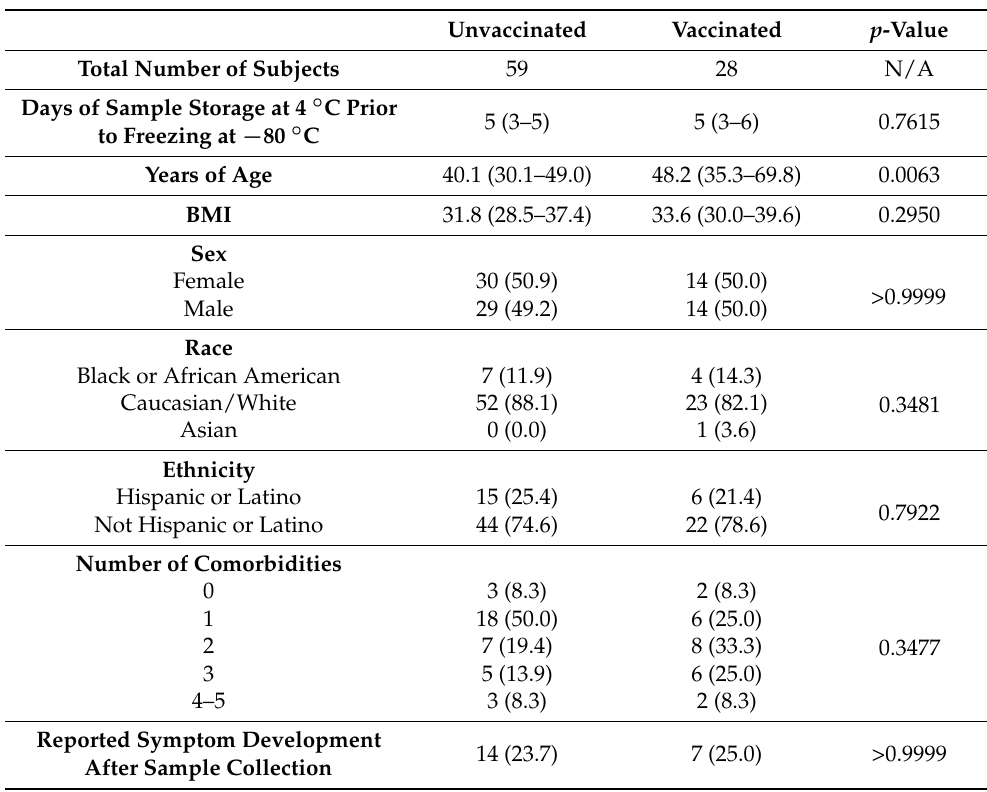
Table 1. Characteristics of the Study Population. Unvaccinated Vaccinated p -Value Total Number of Subjects 59 28